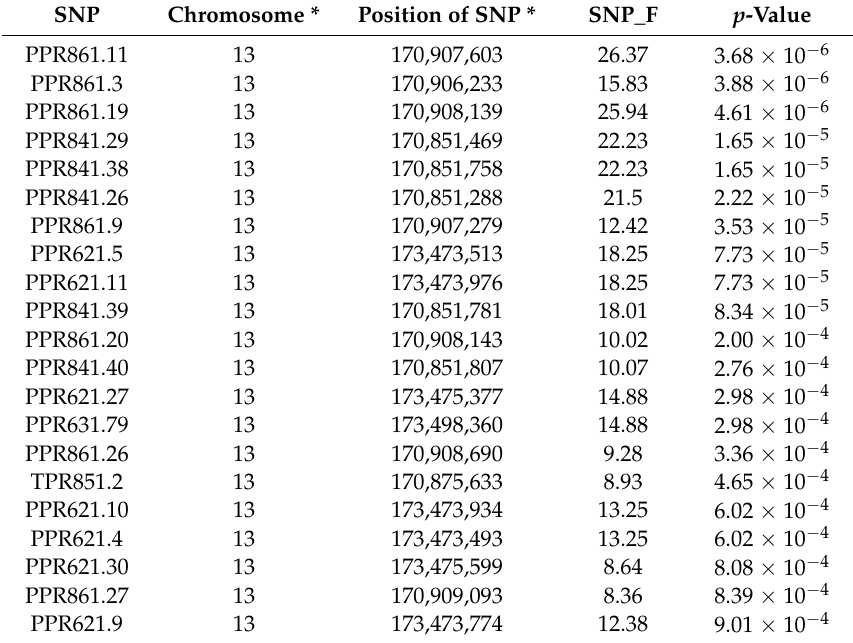
* Position of SNP in accordance with the sunflower genome sequence HanXRQ.